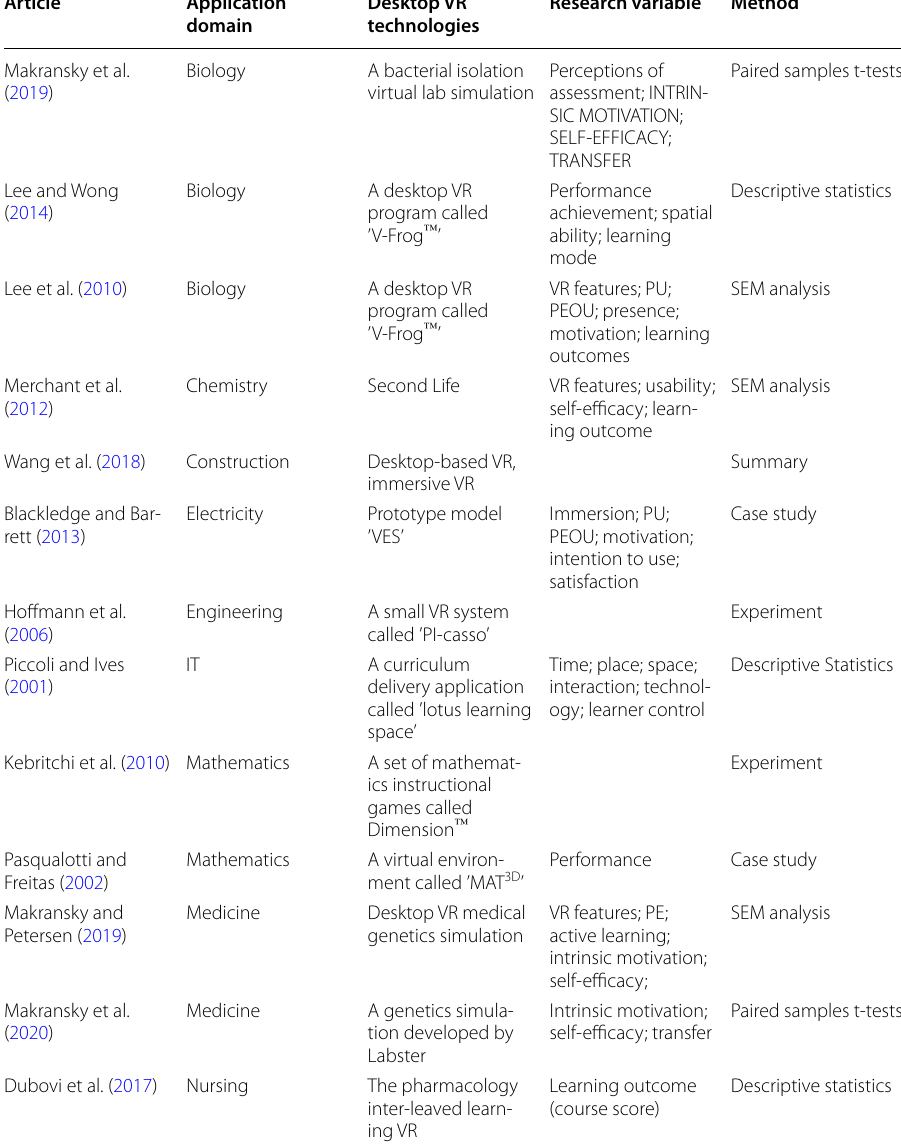
Table 1 A selected review of research on desktop VR technologies in different application